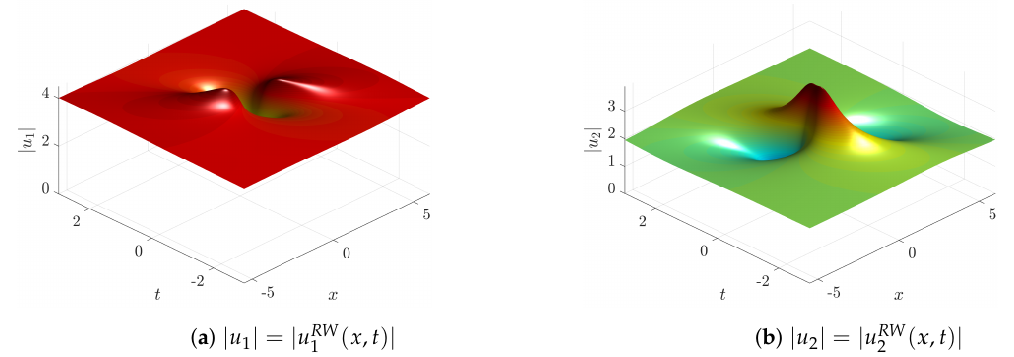
Figure 8. RW solutions corresponding to the spectrum 1 G 1 B 0 L . q = 1, s 1 = s 2 = 1 (defocussing), r = 12, p = 20 ( a 1 = 4, a 2 = 2); λ c = 3.282 + 3.607 i , c = c 2 = 0, c 1 = 1, max | u RW ( x , t ) | / a = max | u RW 2 2